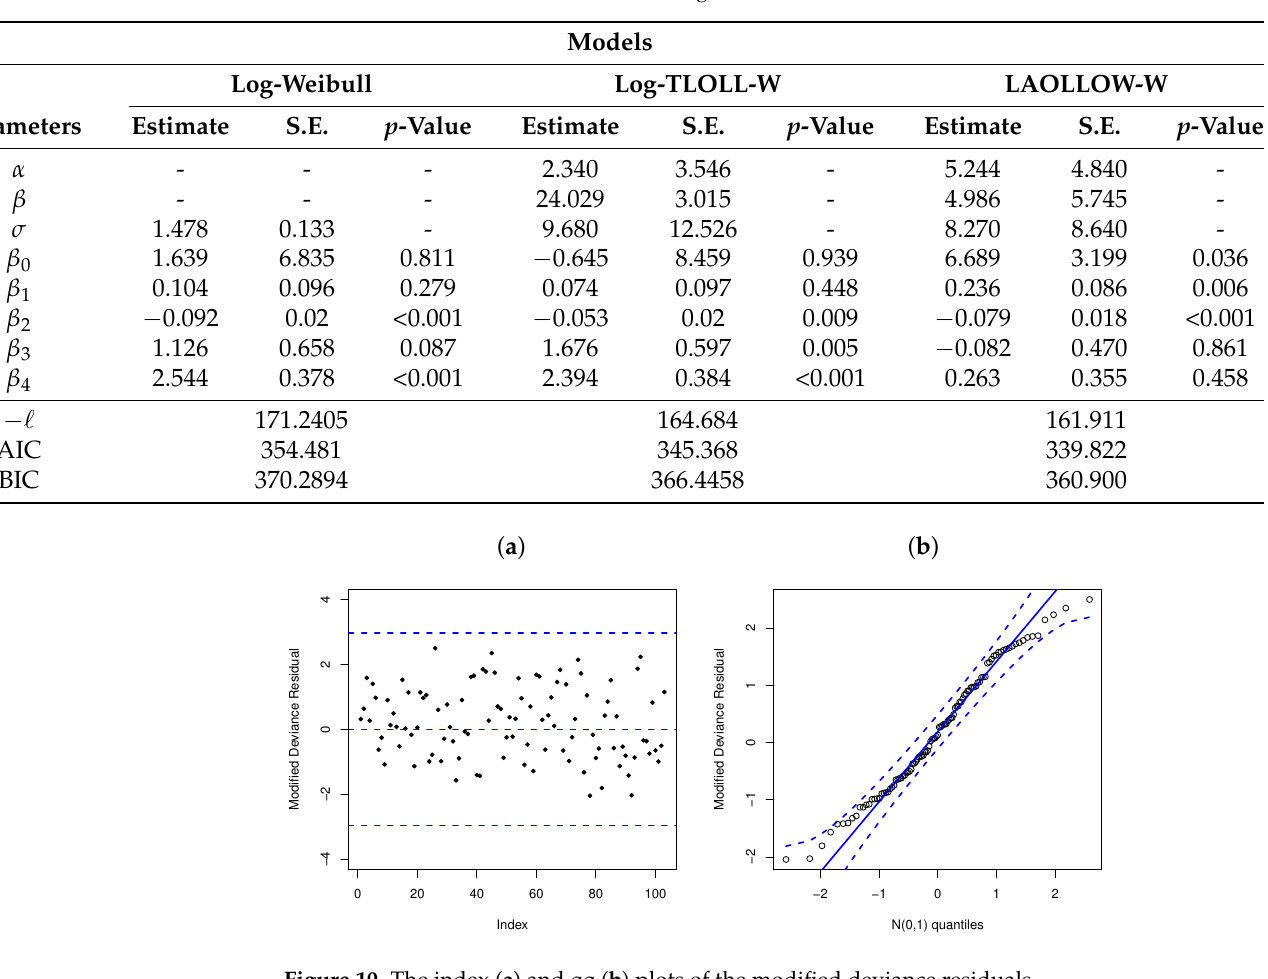
Figure 10. The index ( a ) and qq ( b ) plots of the modified deviance